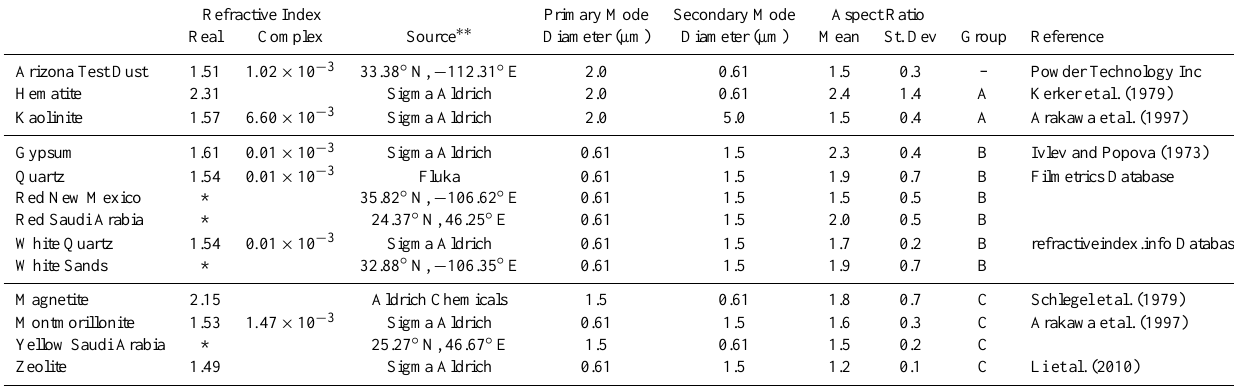
Table 1. Properties of the dust type included in this study.